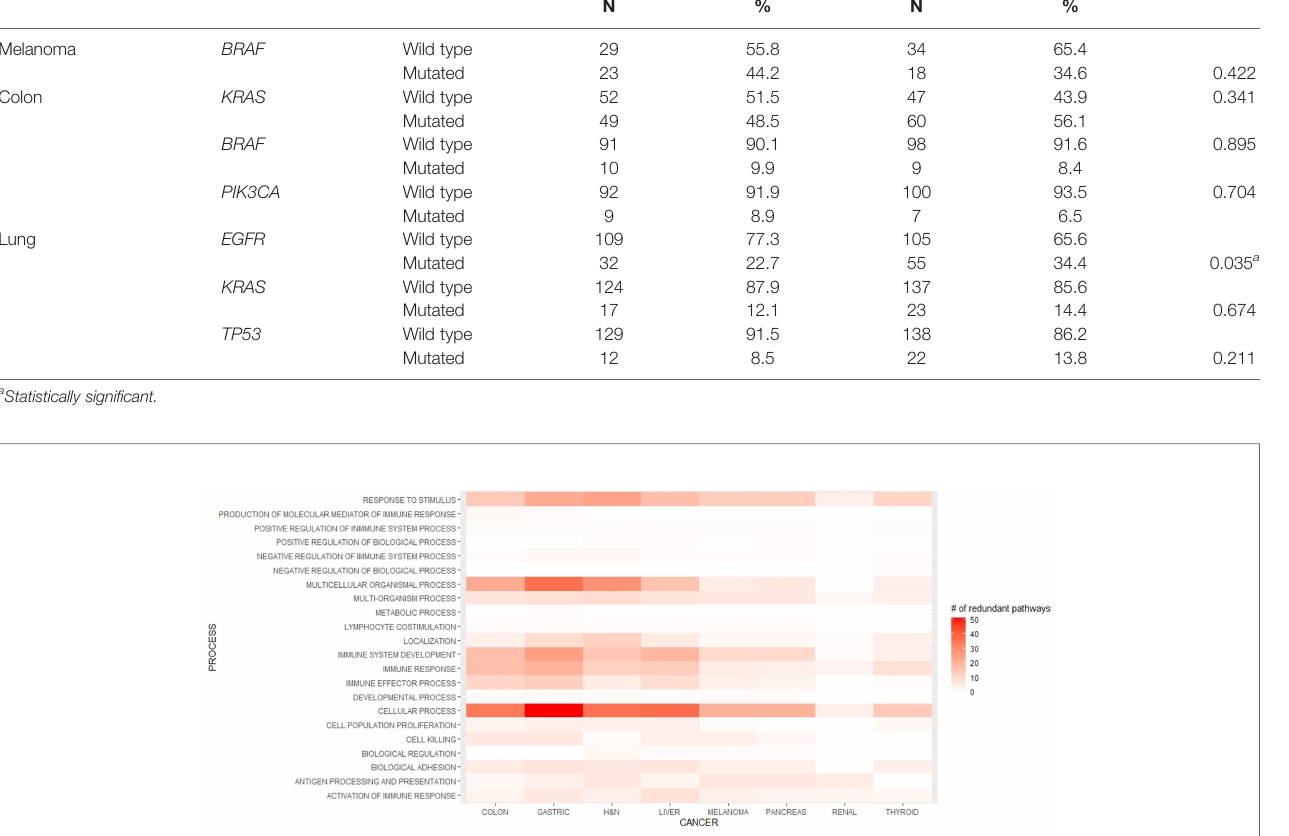
TABLE 2 | Association between mutation status and sex in melanoma, colon, and lung cancer patients. Cancer type